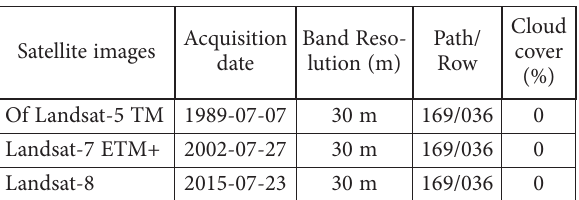
Table 1. Landsat image catogaries used in this study Satellite